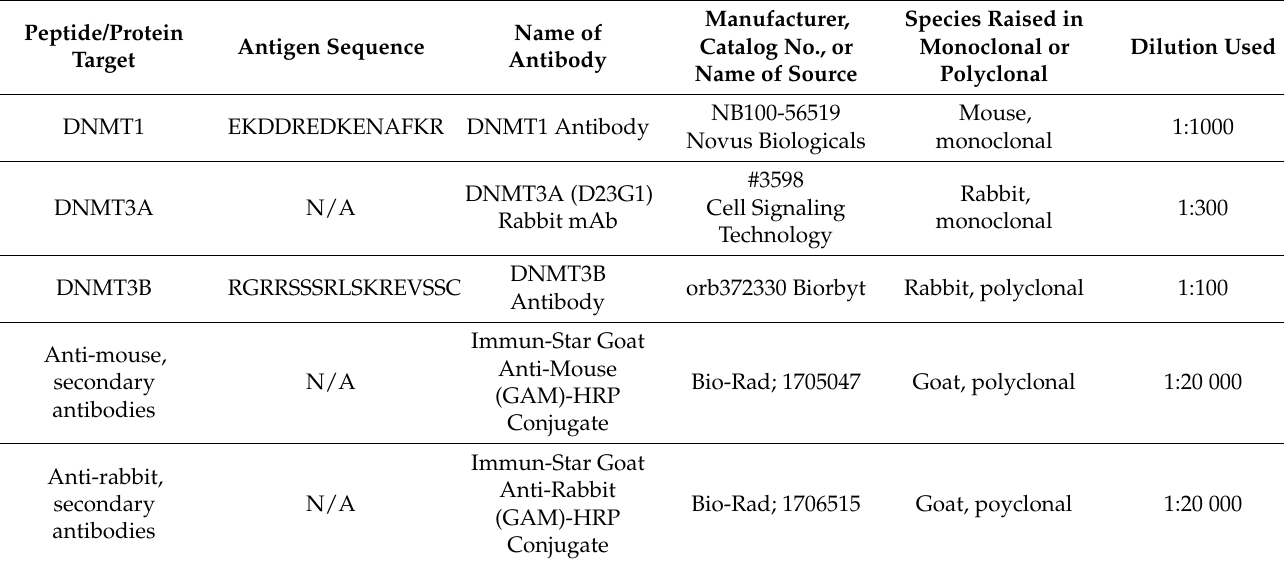
Table 1. List of antibodies used in Western blot